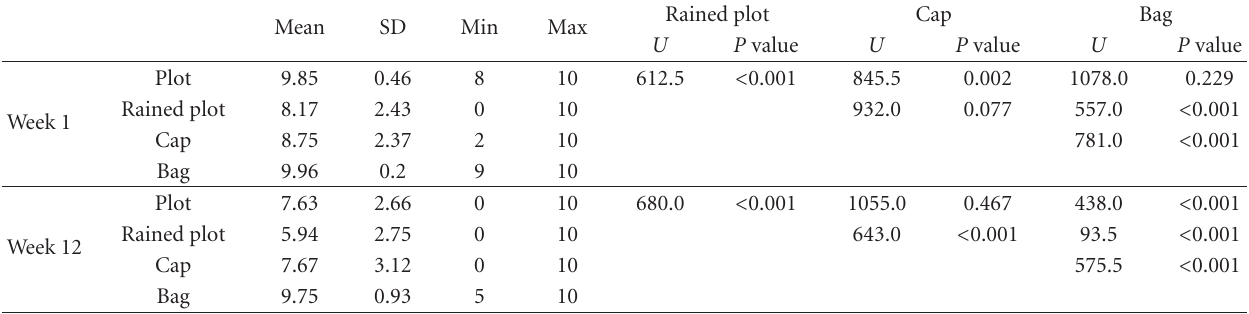
Table 6: Number of scats remaining at week 1 and week 12 in the di ff erent treatments ( N = 48 per treatment, see text) and statistical di ff erences between treatments ( P values and Mann-Whitney U test statistics, Bonferroni’s adjustment α =